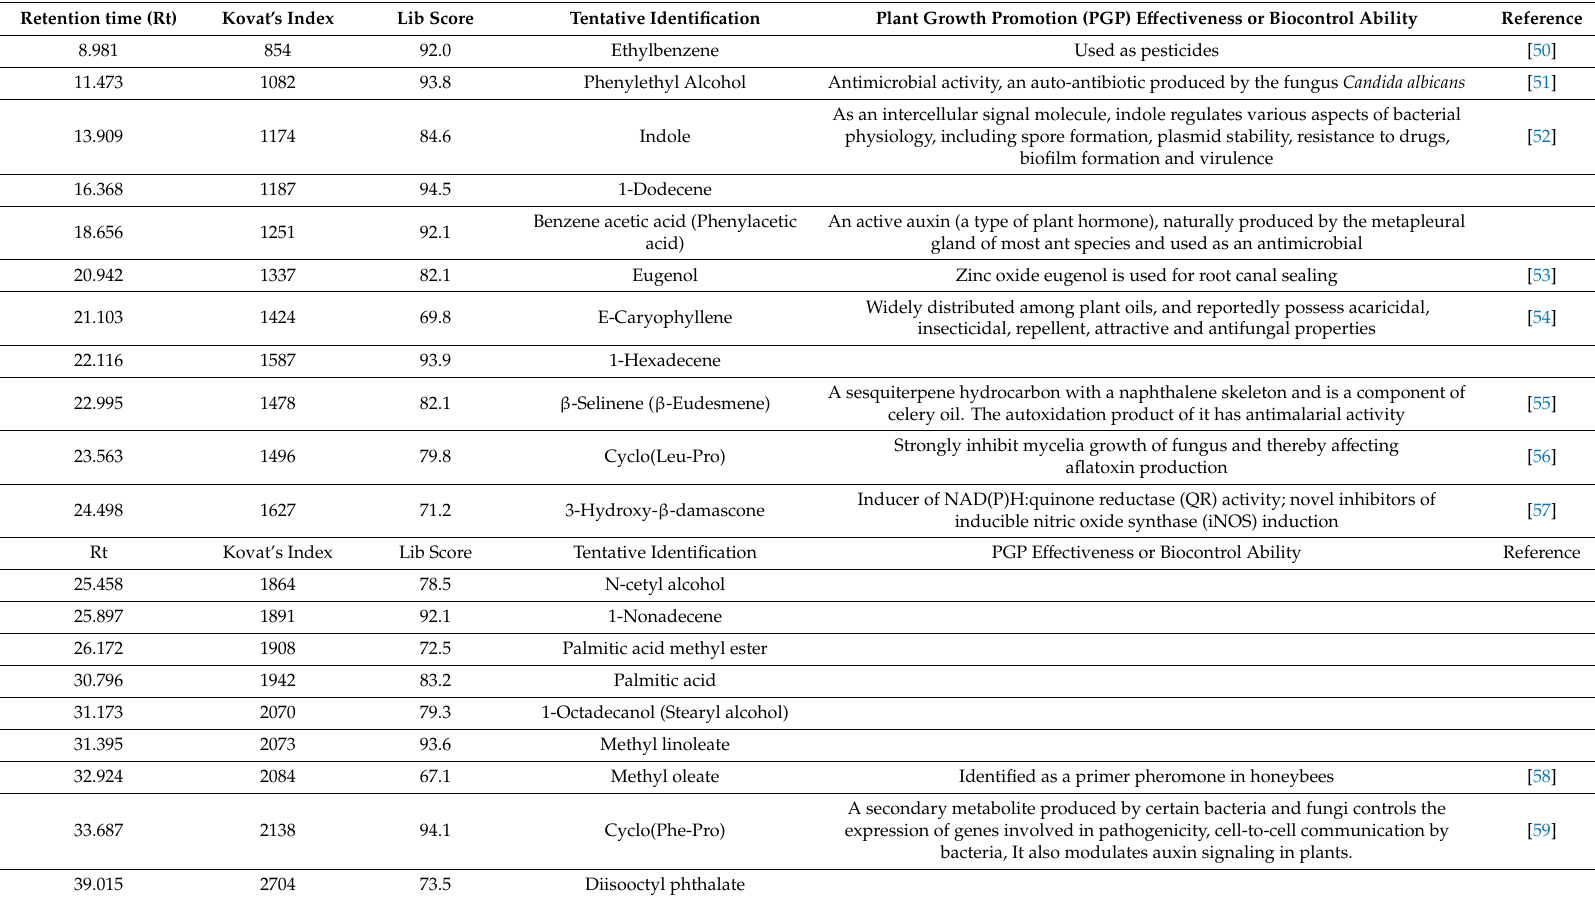
Table 1. Results retrieved from the GC-MS analysis of the B. velezensis strain